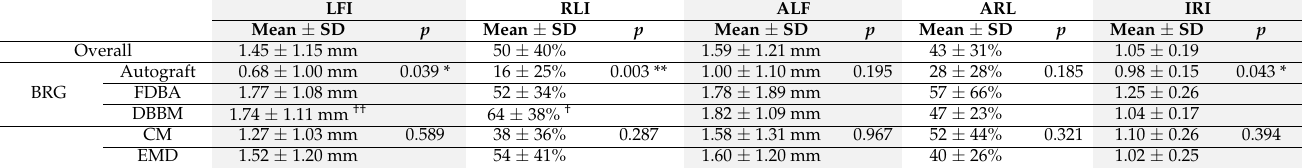
Table 1. The outcome of FDR in the pure furcation defect group based on treatment strategies.